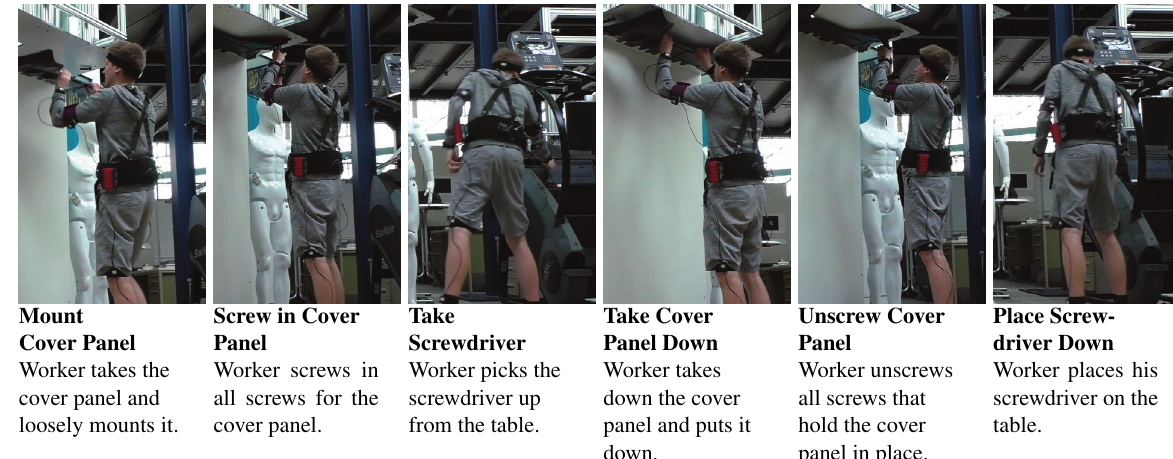
Table 1. High level description of the custom dataset